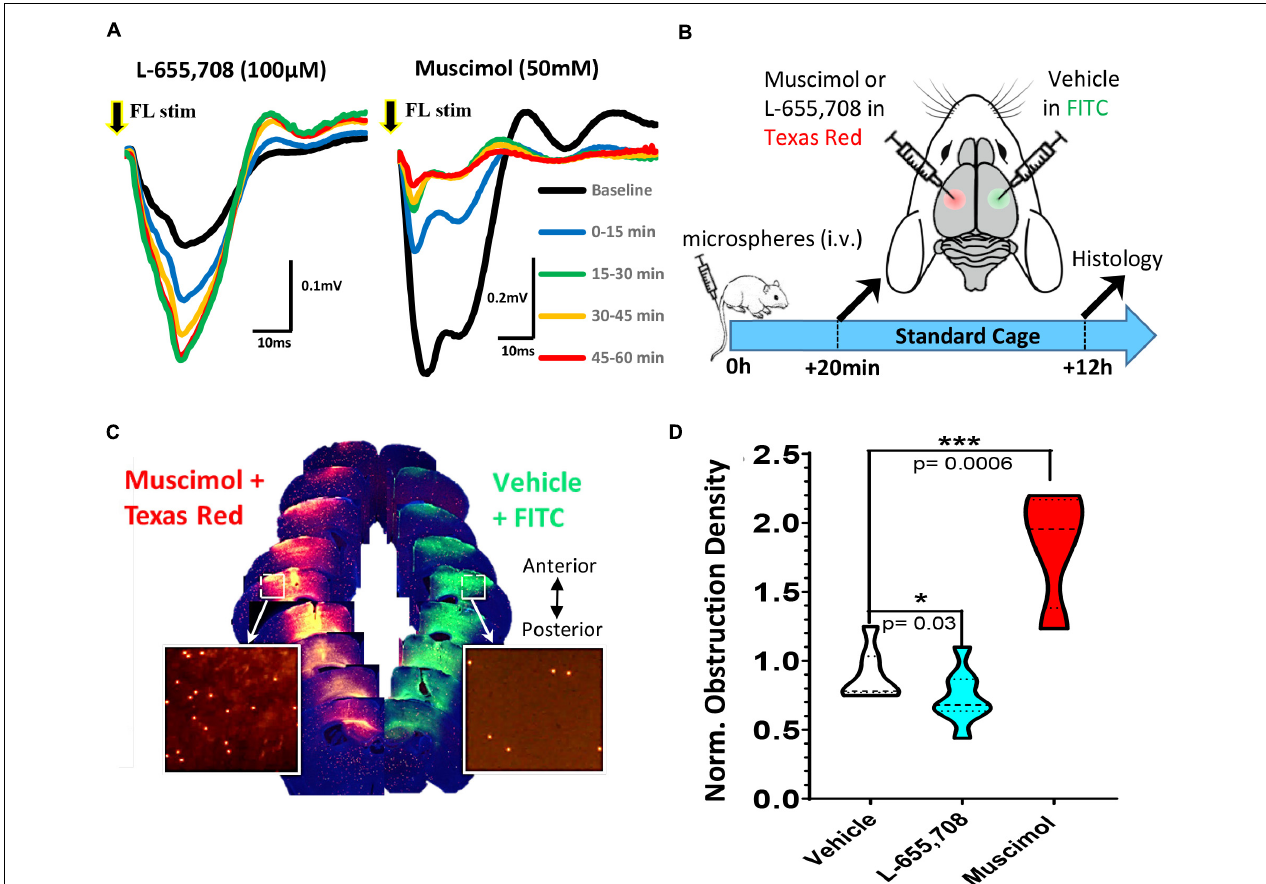
FIGURE 3 | Pharmacological modulation of neuronal excitability reveals bi-directional regulation of cortical capillary recanalization. (A) Field potentials were recorded in the right forelimb somatosensory cortex (FLS1) in response to a single 5 ms deflection of the contralateral forelimb either at baseline (black trace) or after topical application of 100 µ M L-655,708 (left panel) or 50 mM muscimol (right panel). Each trace represents the average of 90 stimulation trials delivered over 15 min epochs. Note the rapid and sustained increase in response amplitude after L-655,708 or decrease after muscimol. (B) Timeline of pharmacology experiments. Twenty minutes after i.v. injection of microspheres, young adult mice received a microinjection of either L-655,708, muscimol or vehicle (with dextran tracer) into the right somatosensory cortex and a vehicle injection in the opposite hemisphere. (C) Image montage of coronal brain sections (anterior to posterior) showing the diffusion of fluorescent dextrans at each injection site and microspheres remaining after 12 h (inserts). (D) Comparison of normalized cortical obstruction densities (normalized to vehicle/vehicle injection control group) in each treatment group. L-655,708 significantly reduced obstruction density compared to vehicle injected